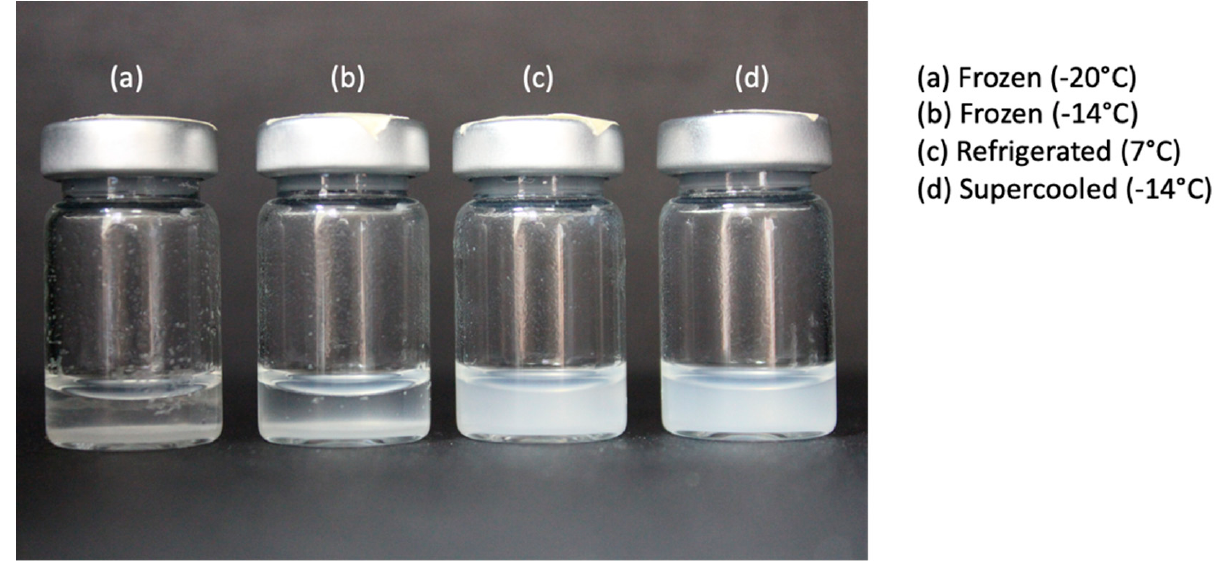
Figure 4. Snapshots of supercooled and control vaccines after shake tests. Test vials ( a , b ) were stored frozen at − 20 °C and − 14 °C (without OMF treatment) for 24 h, and then thawed before commencing the shake tests. Vial ( c ) was refrigerated at 7 °C and vial ( d ) was subject to supercooling treatment for 24 h.